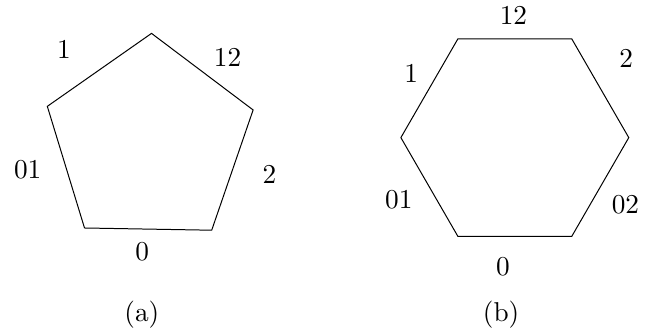
Figure 1 . Facets of the 2d associahedron (a) and permutohedron (b) as generalized permutohedra. This polygon has 5 facets which correspond to the sets ff 0 g ; f 1 g ; f 2 g ; f 0 ; 1 g ; f 1 ; 2